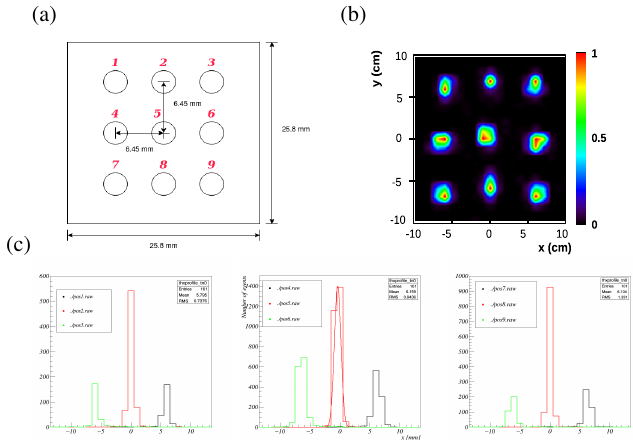
y-profilesthroughtestvoxelsumming(5,5,0)neighboursin(x,y,E)——Position1.raw——Position2.raw——Position3.raw——Position4.raw x-profilesthroughtestvoxel,z-integrated——Position1.raw——Position2.raw——Position3.raw——Position4.raw Fig. 6: Reconstructed position (transverse (a) and sagittal (b) planes) of the point-like source in four different positions (20 mm apart) along the centre of the scanner tube (z-axis). Profiles of the reconstructed data through the x-axis (c) and y-axis (d).